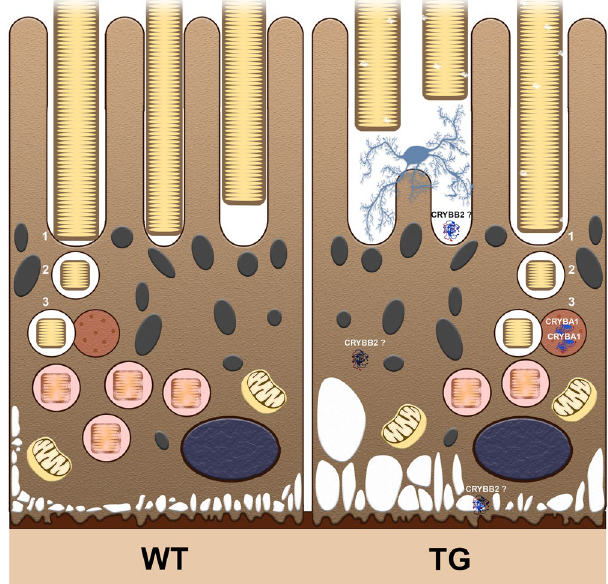
dark blue). In healthy cells (on the left), POS are recognized by microvilli (1) and phagosomes containing shed POS are internalized (2). Finally (3), phagosomes fuse with lysosomes (red vesicle), forming mature acidified phagolysosomes (red vesicles containing POS). In TG mice (on the right), photoreceptors expressing the mutant human ELOVL4 protein have outer segment ultrastructural abnormalities. Presentation of these segments to RPE cells leads to impaired phagolysosome maturation. Less acidified phagolysosomes are detected during the burst of phagocytic activity (2 hours after light onset). Lysosomal protein CRYBA1/A3 levels remain abundant (3 and 5 hours after light onset). Vacuoles (in white) form at the basal RPE. RPE cells produce CRYBB2, a protein present in AMD drusen. Phagocytic cells (microglia/macrophages, pale blue) are recruited to the subretinal